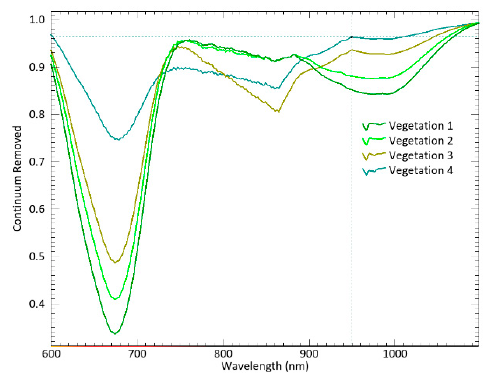
Figure 7. Results of the continuum removal transformation for the discriminated vegetation classes in the salt marsh of Cadiz Bay. Note that vegetation 1 and 2 have the opposite slope to vegetation 3 and 4 in the 882–949 nm region. and 4 in the 882–949 nm